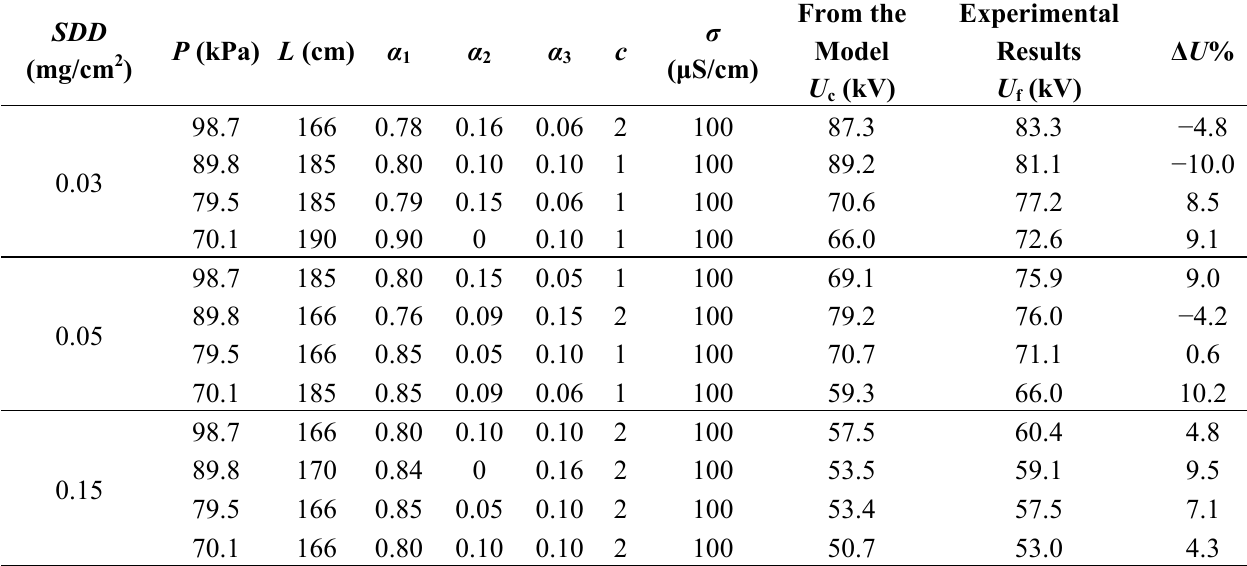
Table 3. Test and calculation results of the DC flashover voltage of the ice-covered 7-unit XZP-210 insulator